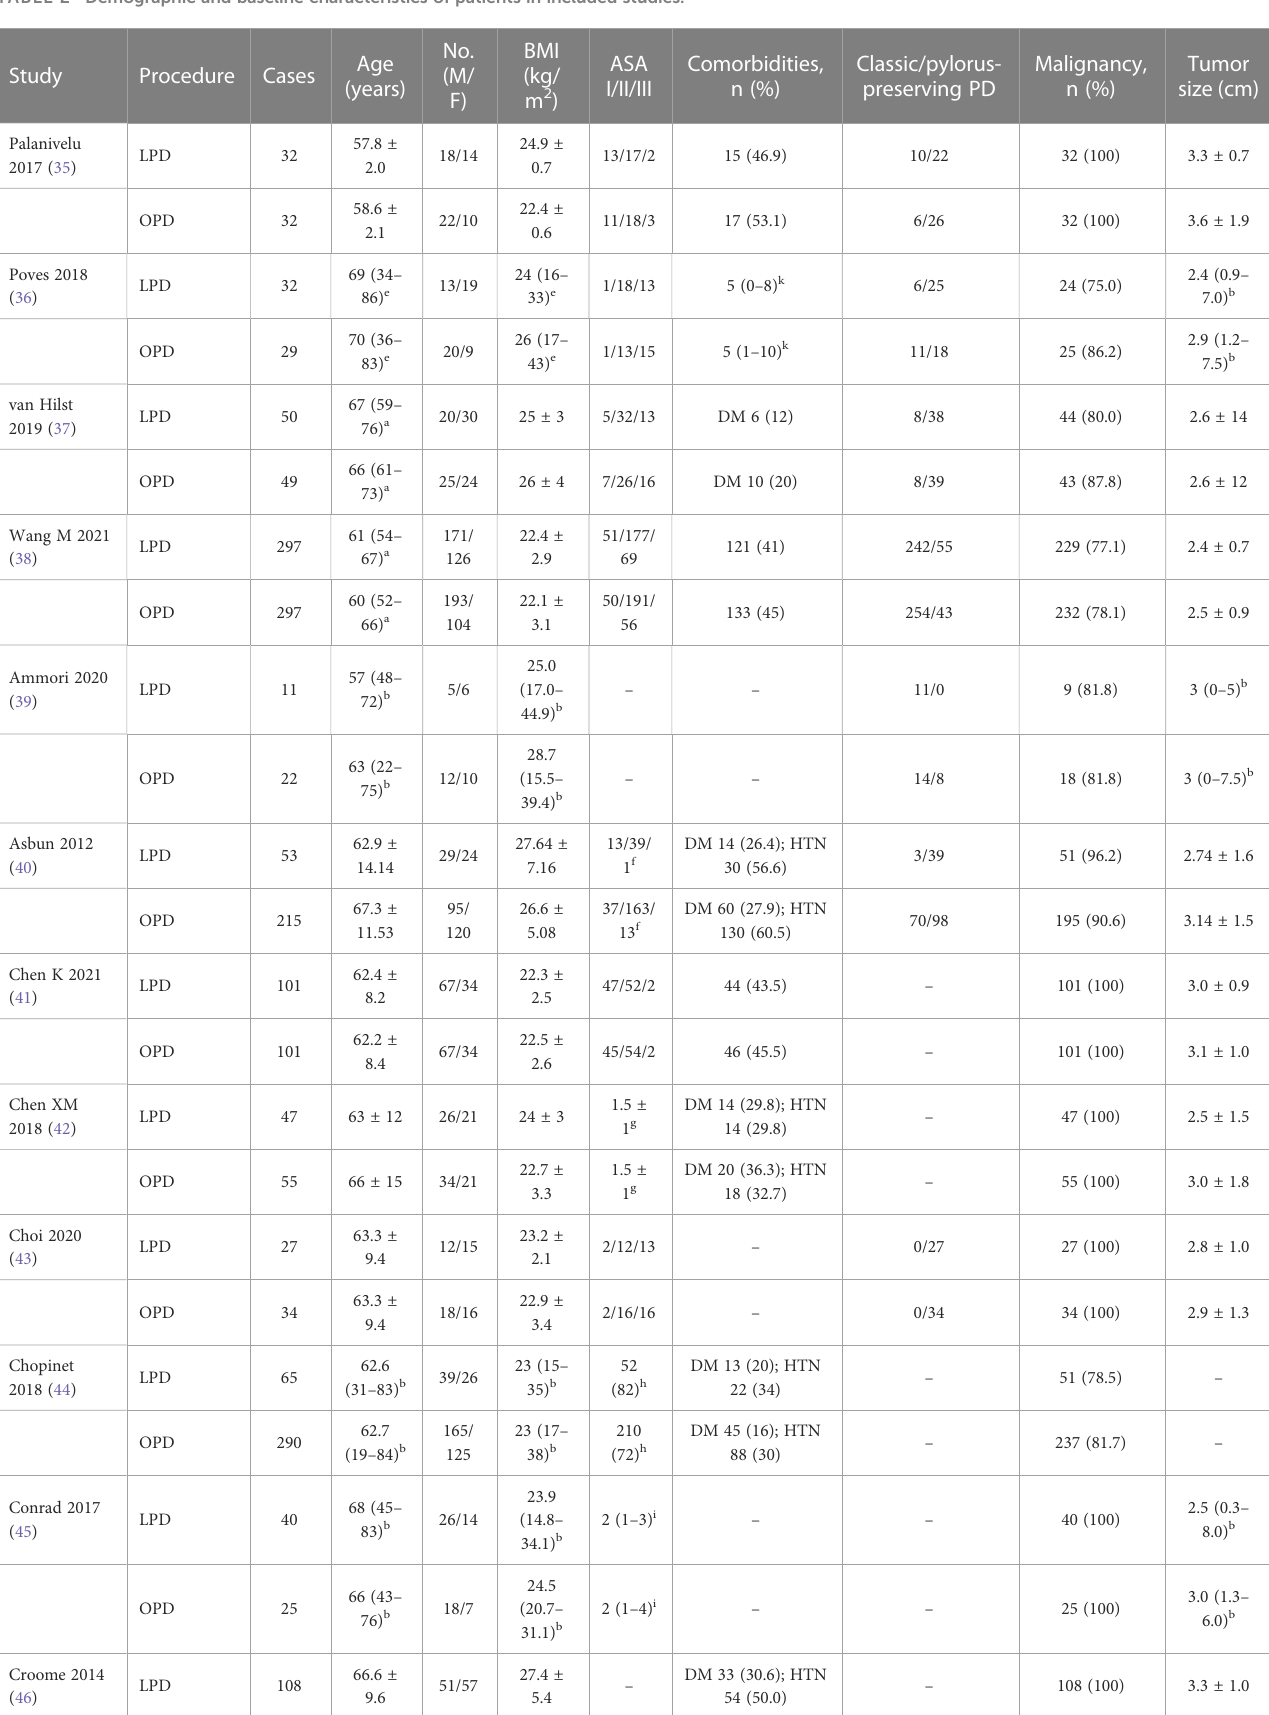
TABLE 2 Demographic and baseline characteristics of patients in included